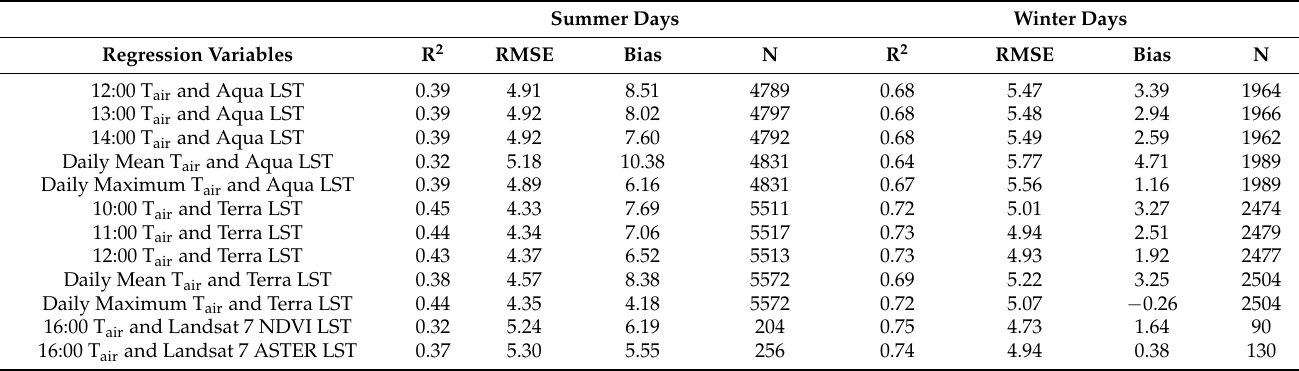
Table 5. Detailed results from regression analyses conducted using both MODIS satellites and Landsat 7 against air temperature based on lakeside in situ stations. All p -values are <0.001.